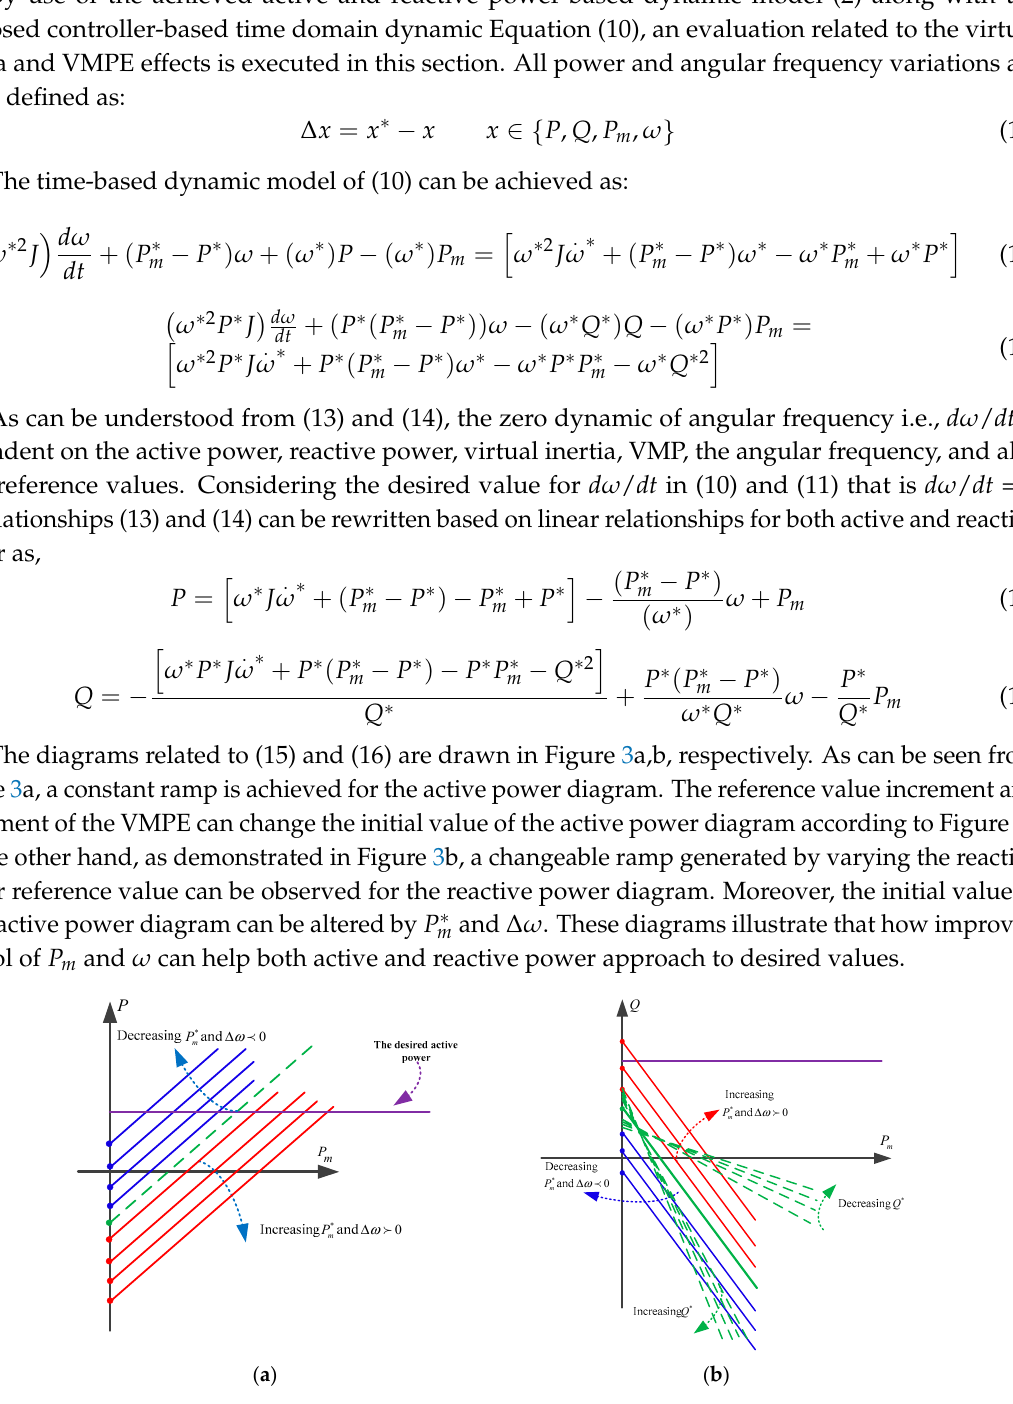
Figure 3. Diagrams of ( a ) the active power based on the virtual mechanical power (VMP) with changing P m * and ∆ ω and ( b ) the reactive power based on VMP with changing P m *, Q * and ∆ ω